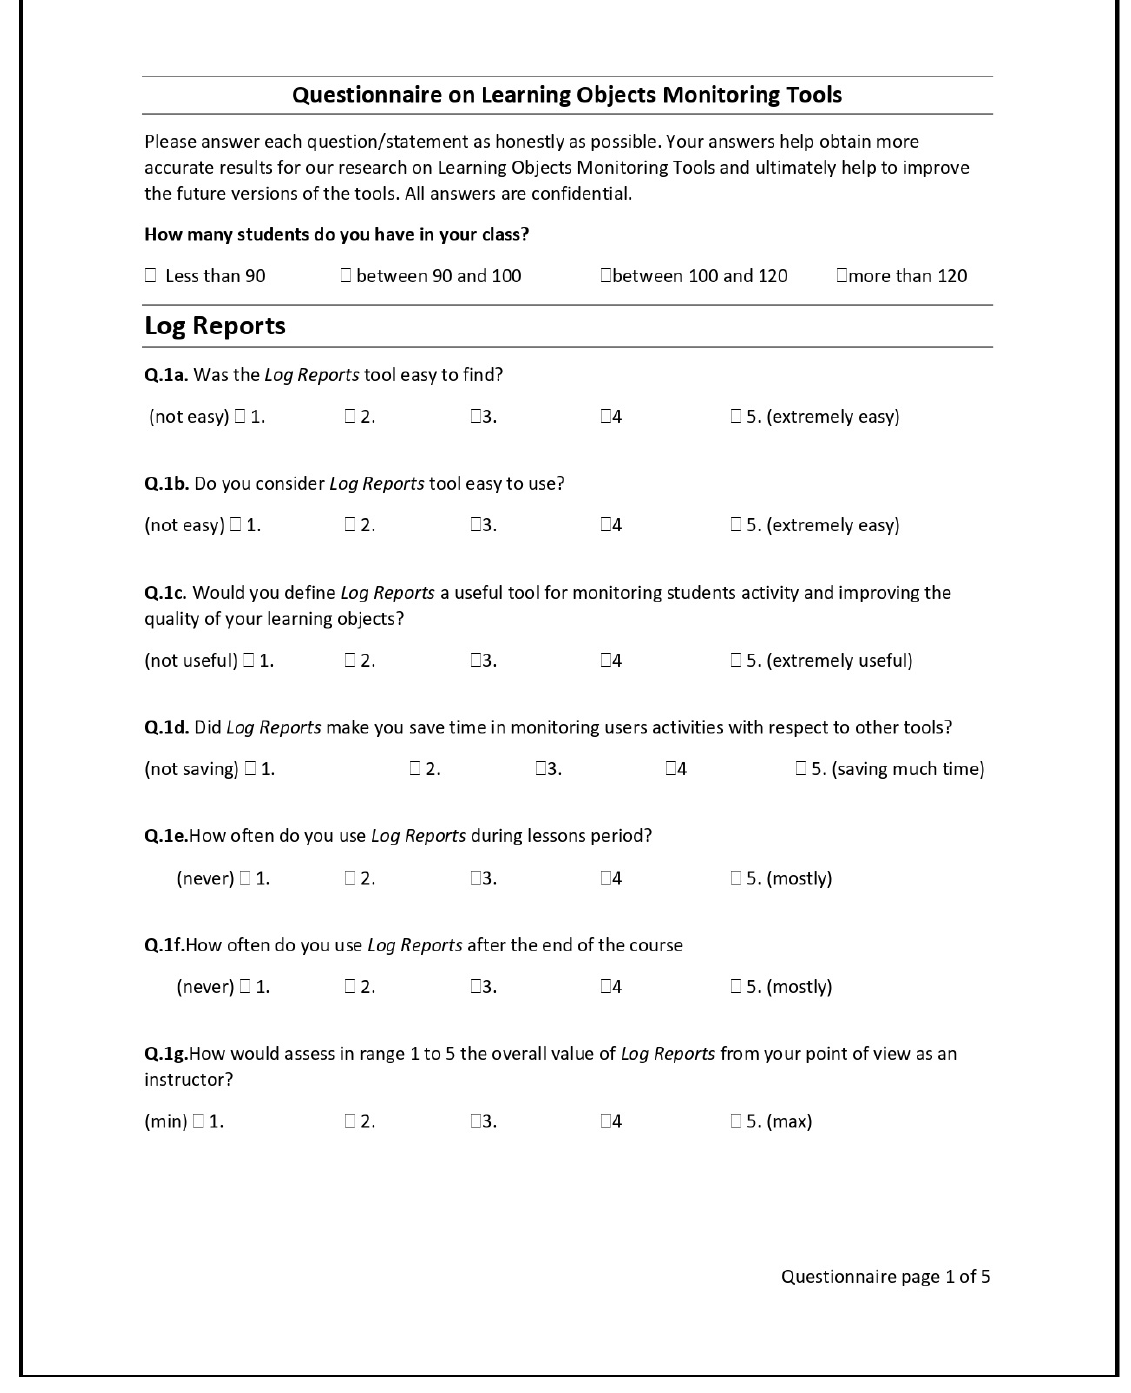
Figure A1. Questionnaire page 1 of